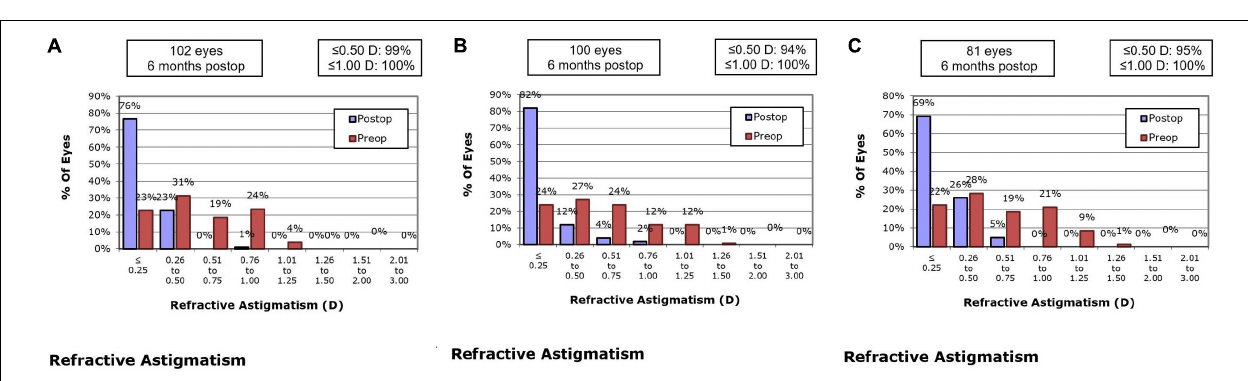
FIGURE 4 | Refractive astigmatism accuracy at postoperative 6-month. (A) SMILE group, (B) wavefront optimized group, (C) topography-guided custom ablation treatment group.